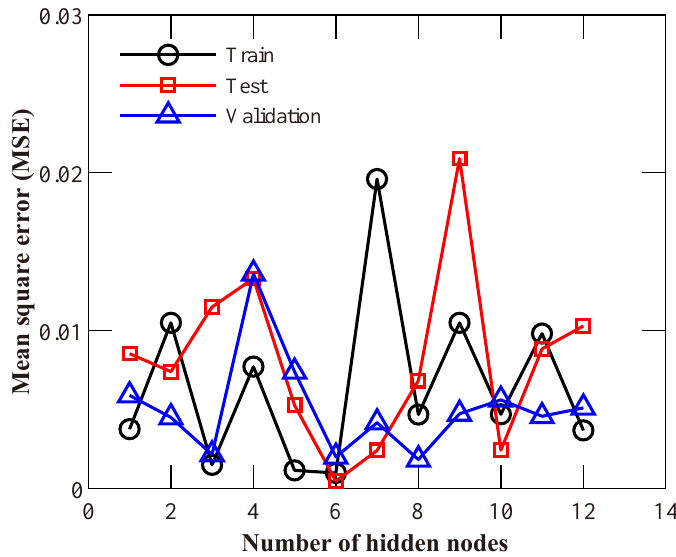
Figure 6. The MSE for different neuron number in the hidden layer.